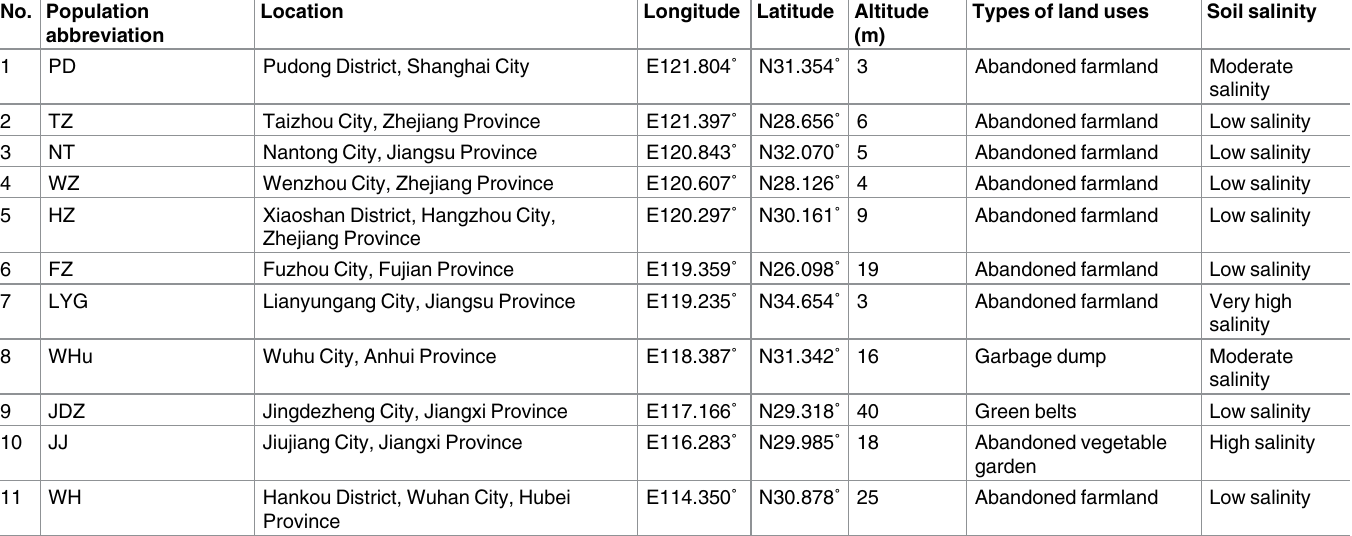
Table 1. Geographical information, types of land use and soil salinity of Solidago canadensis populations. No. Population